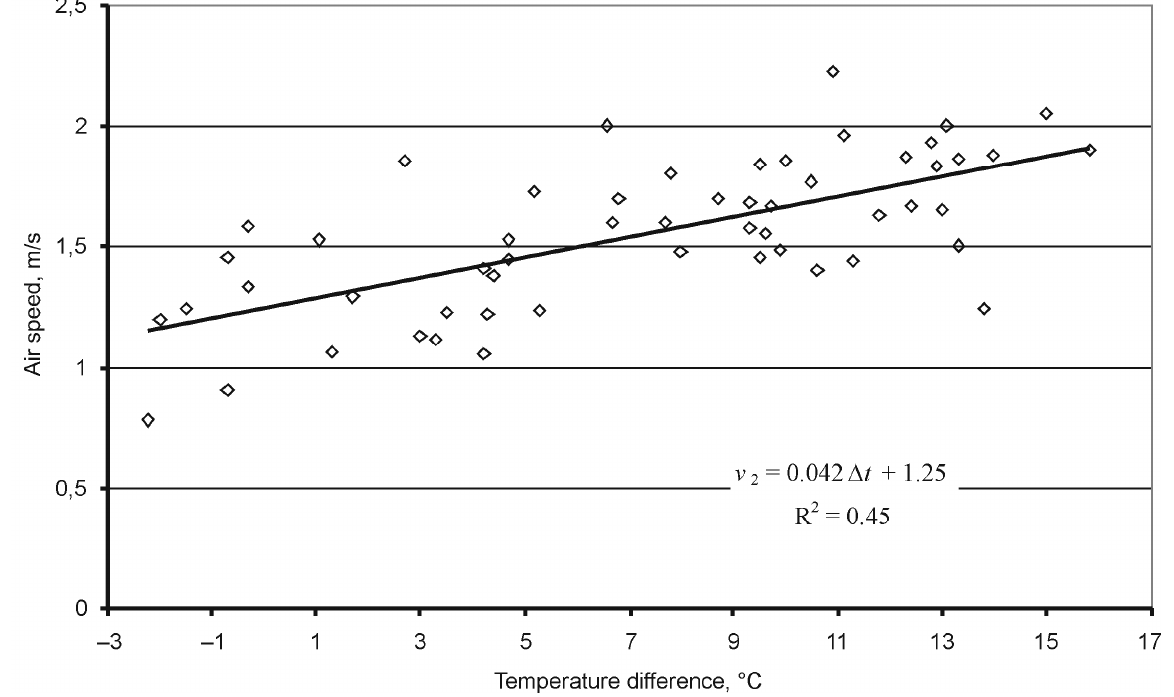
Fig. 3. Experimental dependence of air speed in outlet opening on indoor-outdoor temperature difference. Distance between air inlet and outlet openings is 6.5 m and wind speed – 3.6–4.2